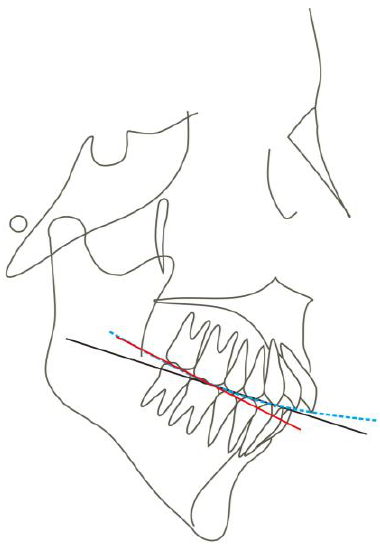
Figure 13. A schematic of skeletal Class II malocclusion with a steep posterior occlusal plane. The black solid line indicates the conventional occlusal plane, blue dotted line indicates the curve of Spee, red solid line indicates the posterior occlusal plane.